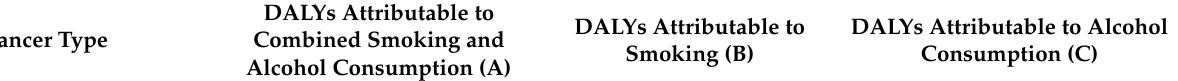
Table 5. Burden of cancers attributable to smoking and alcohol consumption according to sex (unit: